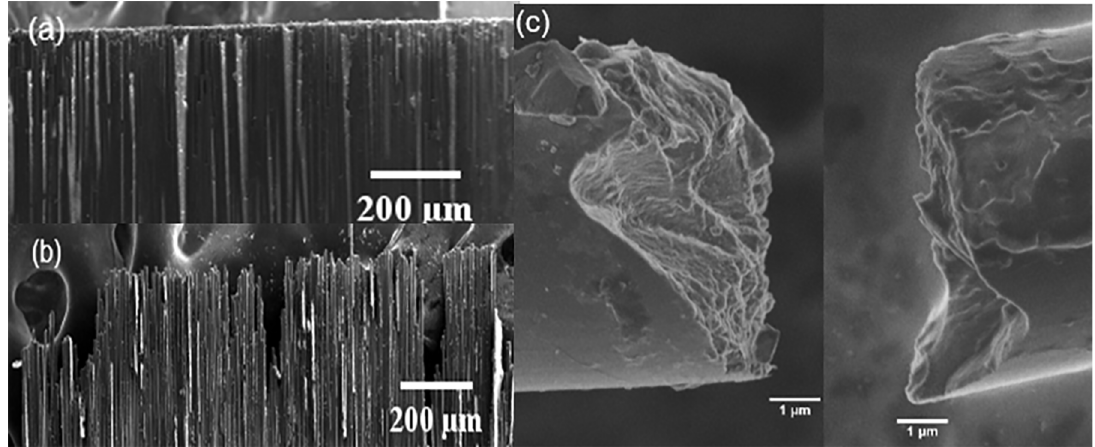
Figure 5. SEM image of Sikacarbodur S512 (a) before the tensile test and (b) after tensile test. (c) SEM image of carbon fiber failure surfaces.